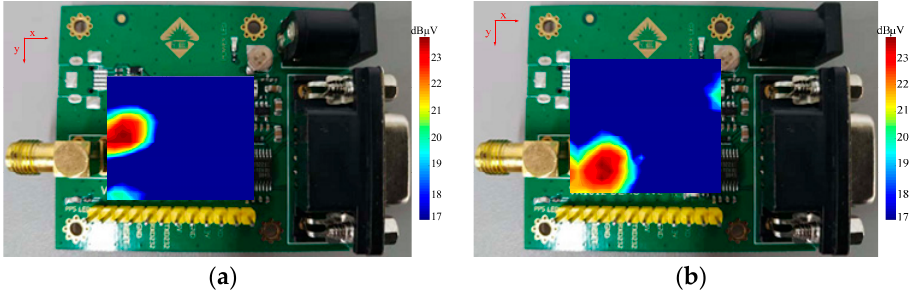
Figure 27. Measured tangential-field distributions of ( a ) Ex and ( b ) Ey, respectively.